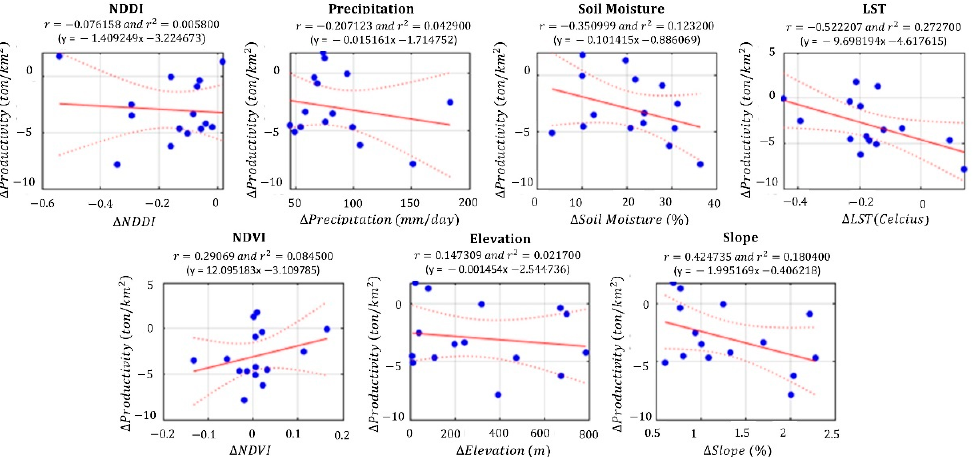
Figure 9. Linear regression between the productivity and environment factors.